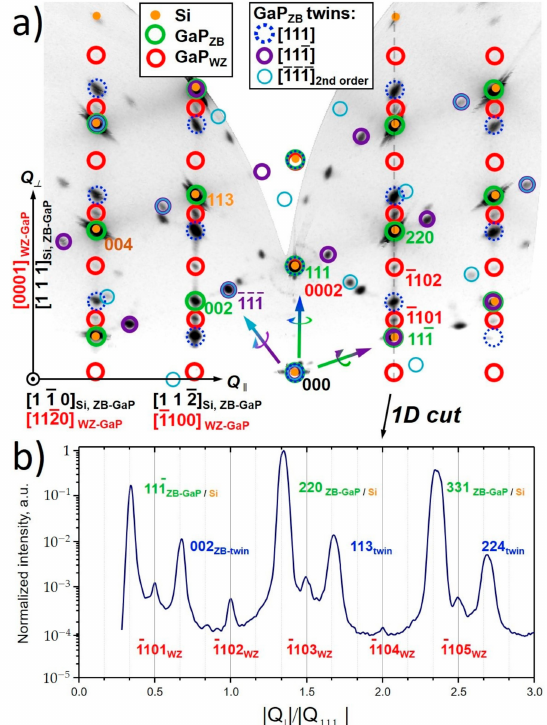
Figure 4. ( a ) Two dimensional XRD reciprocal space cut along [112]Si and [111]Si directions obtained for Sample 2 with superimposed models of Si[110] (orange dots), ZB-GaP [110] (green circles), ZB-GaP 1st (blue dashed and violet circles) and 2nd order rotational twins (turquoise circles) and WZ-GaP [1120] (red circles) zone axis patterns shown with coloured circles, ( b ) Line-cut of the RSM through the off-specular Si (220) diffraction reflex along the [111] direction, demonstrating the relative position of the ZB and WZ reflexes. Q ⊥ —perpendicular component of the diffraction